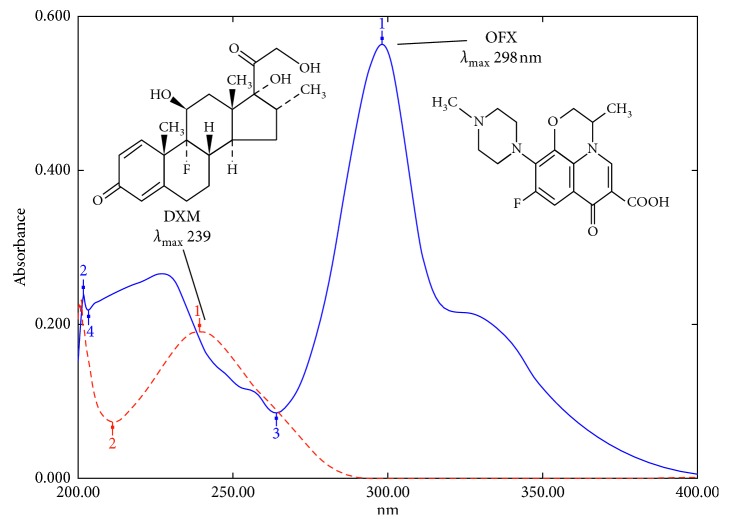
The zero-order spectra (D0) and chemical structures of OFX and DXM showing λmax.